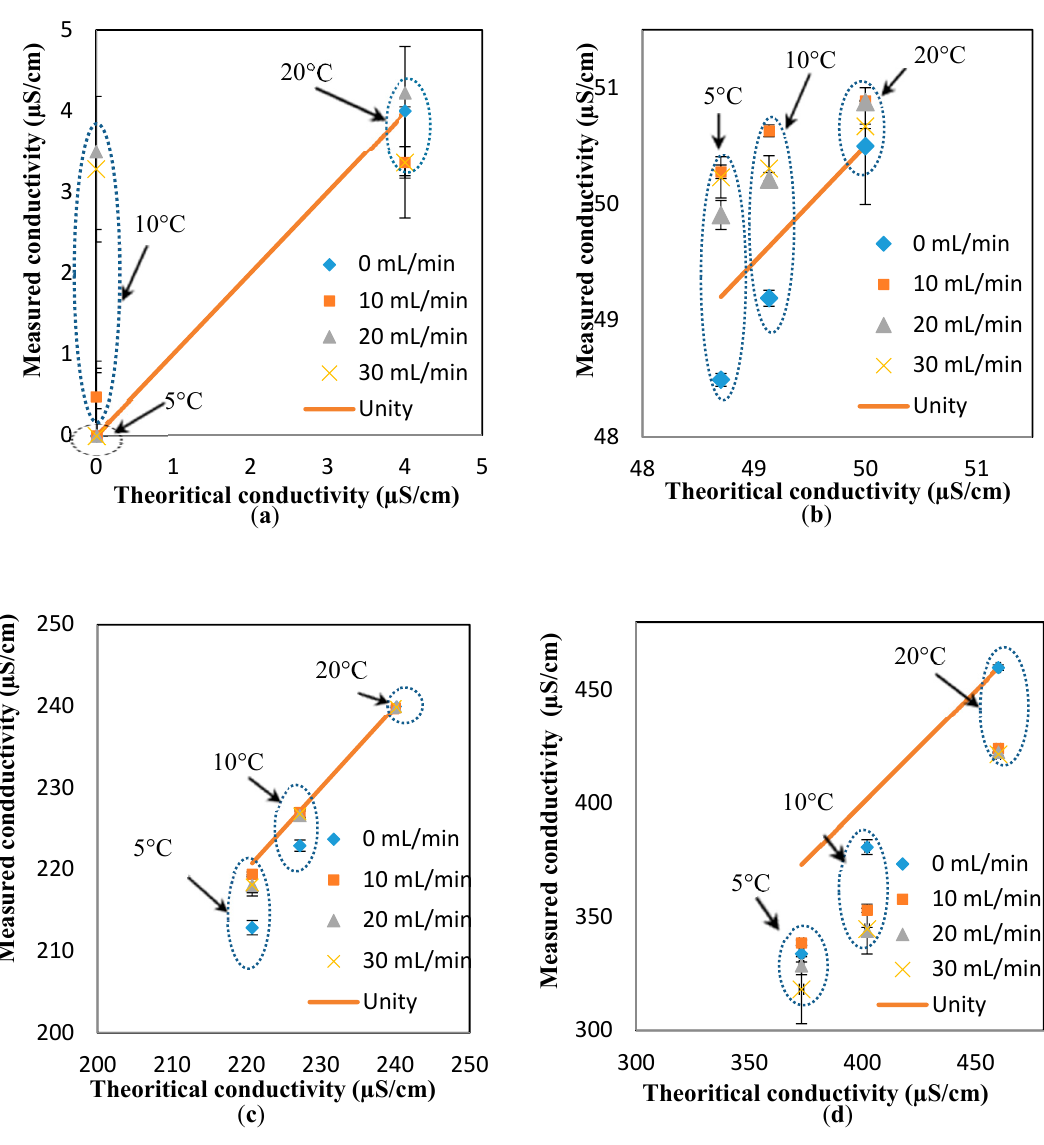
Figure 5. Effect of temperature on the response of the conductivity sensor for different conductivity solutions at flowrates of ( a ) 0 mL/min; ( b ) 10 mL/min; ( c ) 20 mL/min; and ( d ) 30 mL/min.